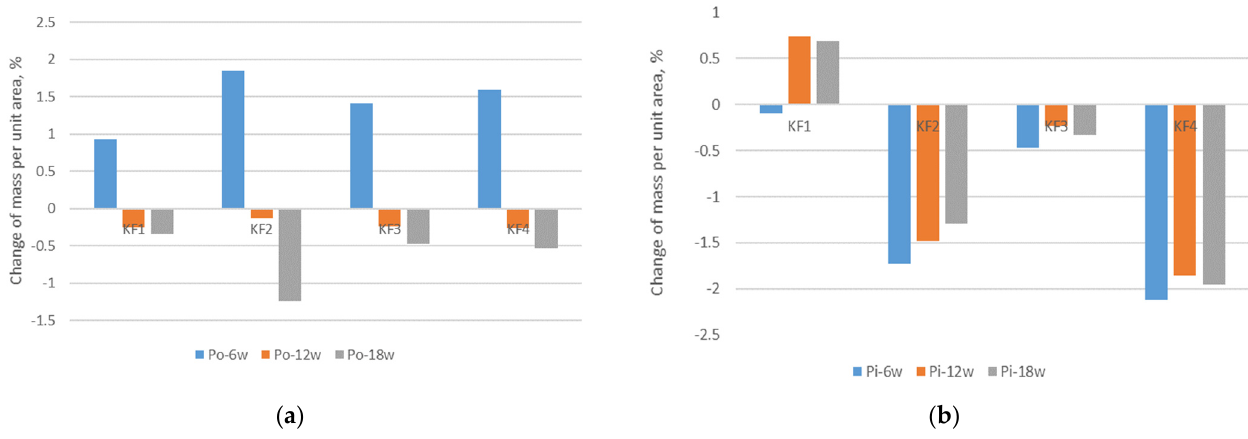
Figure 4. Change in mass per unit area after exposure compared to mass per unit area of non-aged materials: ( a ) outdoor; ( b ) indoor.